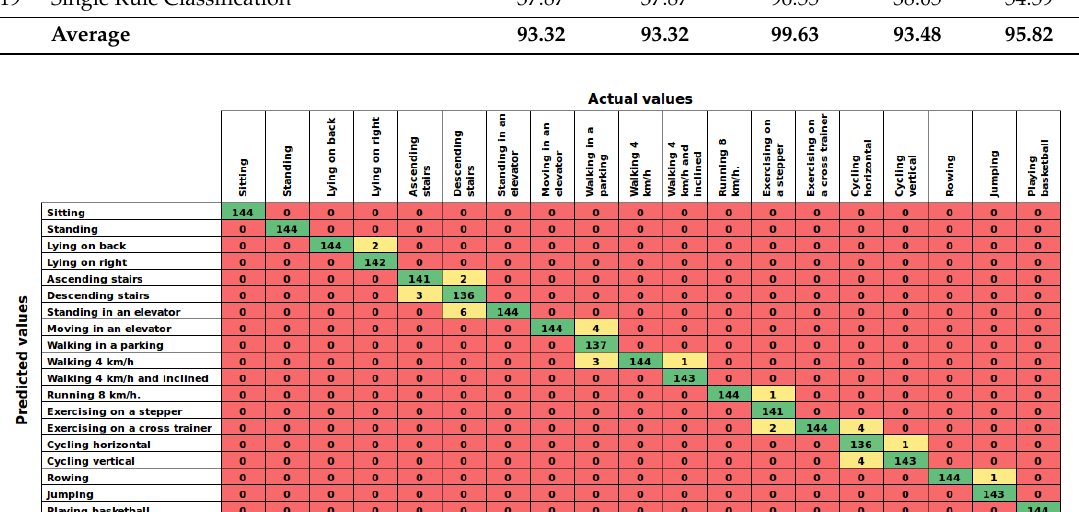
Figure 6. Results of case 1: Confusion matrix of the AHN-classifier in the performance for all subjects using cross-validation. Numbers represent window